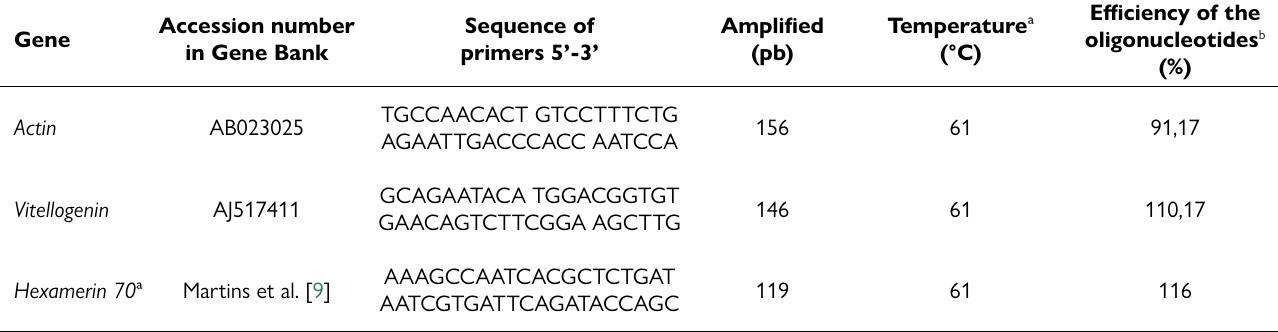
Table 1. Oligonucleotides used in gene expression study of Apis mellifera that were fed different energetic foods during the off-season.